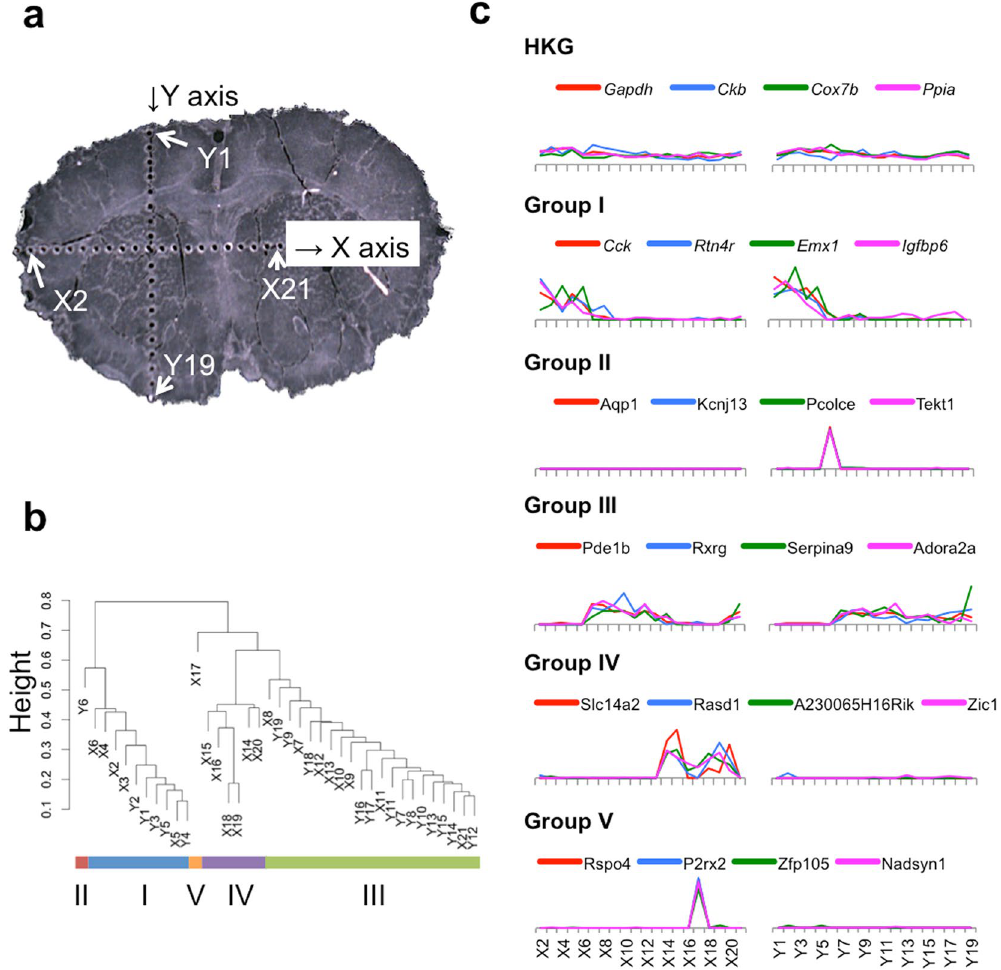
Figure 3. Site-specific gene expression. ( a ) Frozen mouse brain slice after the removal of micro-dissections. ( b ) Hierarchal clustering of micro-dissections based on gene expression. ( c ) Typical site-specific gene expression patterns. The expression levels were normalized by the average TPM for each